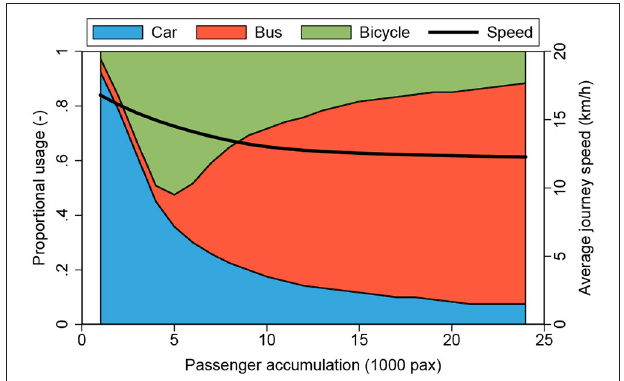
FIGURE 4 | Optimal mode shares and average journey speed given the current vehicle accumulation based on the calibrated tri-modal MFD